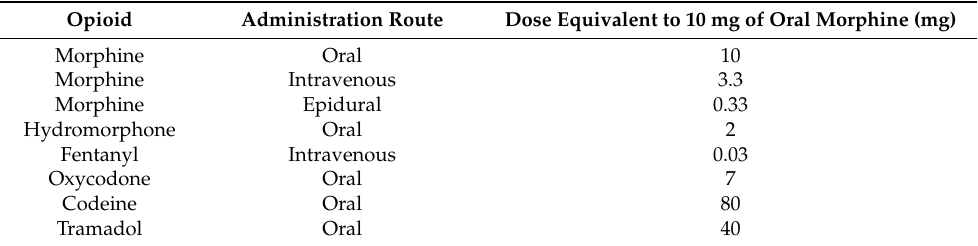
Table A1. Equianalgesic opioid conversion table.